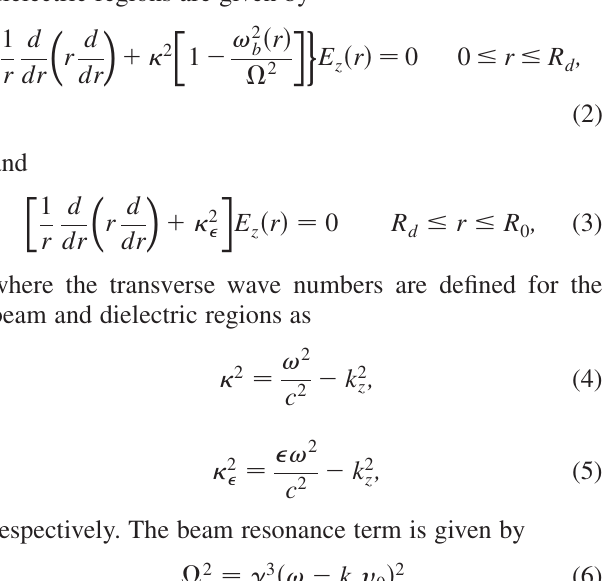
for 0 (cid:2) r (cid:2) R . The solution for the axial electric field in d